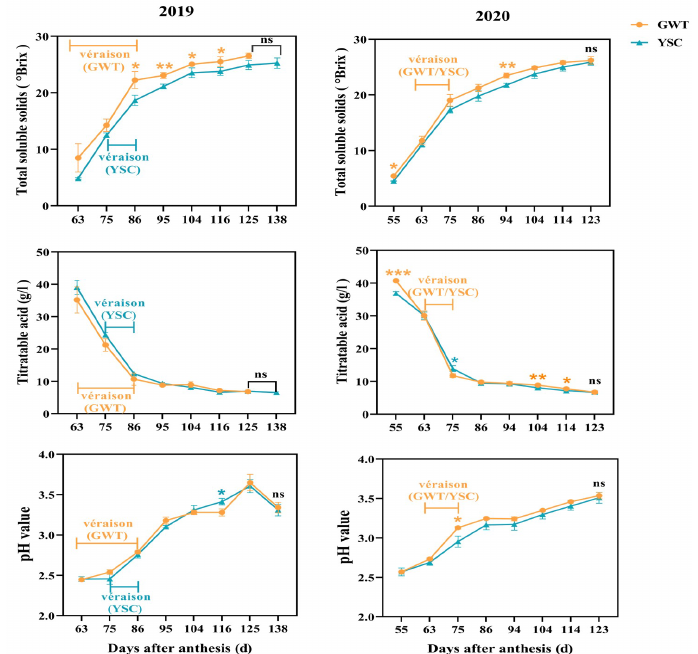
Figure 1. Changes in total soluble solids, titratable acid content, and pH value during ripening of ‘Cabernet Sauvignon’ grapes from two vineyards in 2019–2020. In 2019, ‘Cabernet Sauvignon’ grapes from the GWT entered the v é raison stage at 63 DAA, full coloring stage at 86 DAA, and commercial harvesting stage at 125 DAA. The grapes from the YSC started coloration at 75 DAA, full coloring at 86 DAA, and commercial harvesting at 138 DAA. In the 2020 vintage, grapes from both vineyards started v é raison at 63 DAA, full coloring at 75 DAA and commercial harvesting at 123 DAA/The asterisk indicates that there is a statistical difference between the 2 vineyards in the same period at the 0.05 level: *, p < 0.05; **, p < 0.01; ***, p < 0.001; ns, not